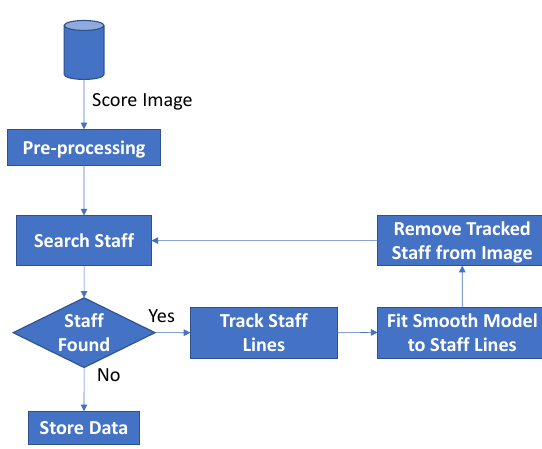
Figure 2. General scheme of the staff reconstruction